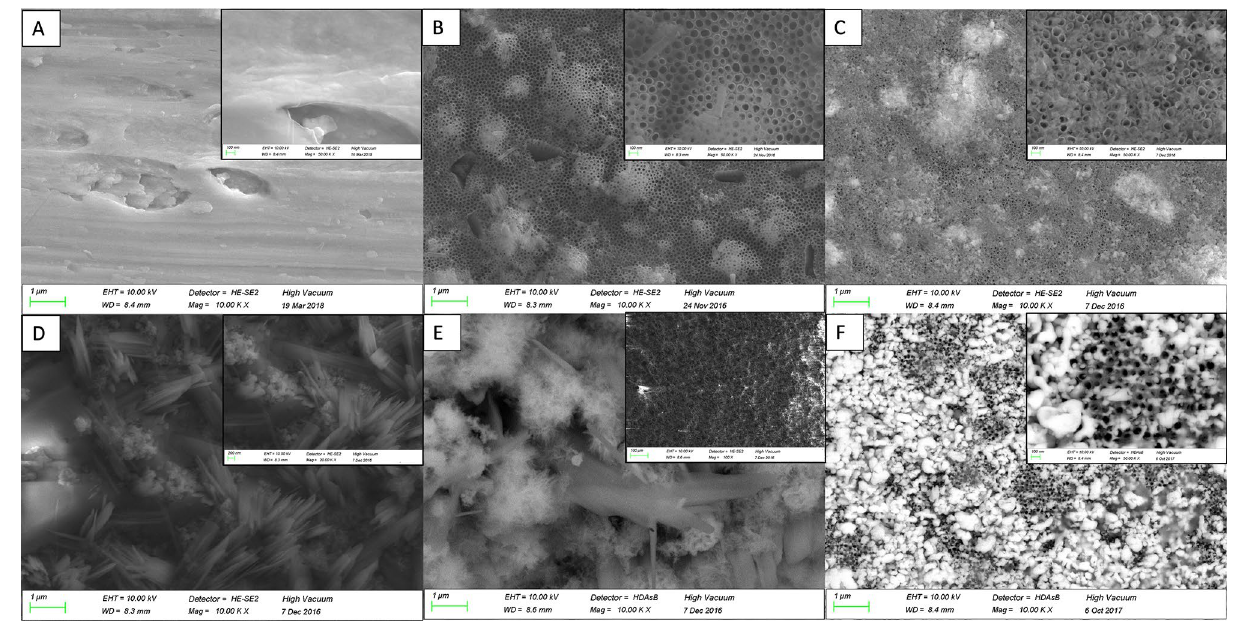
Figure 1. Scanning electron microscope (SEM) images of the discs’ surfaces: ( A ) unmodified control; ( B ) phospate-doped titantium nanotubes (pTNT); ( C ) selenium-incorporated phosphate-doped TiO 2 -nanotubes (SepTNT); ( D ) hydroxyapatite coated (HA) phosphate-doped TiO 2 -nanotubes; ( E ) selenium incorporated phosphate-doped TiO 2 -nanotubes with hydroxyapatite coating (SepTNT-HA); ( F ) silver-selenium incorporated phosphate-doped TiO 2 -nanotubes (Ag 2